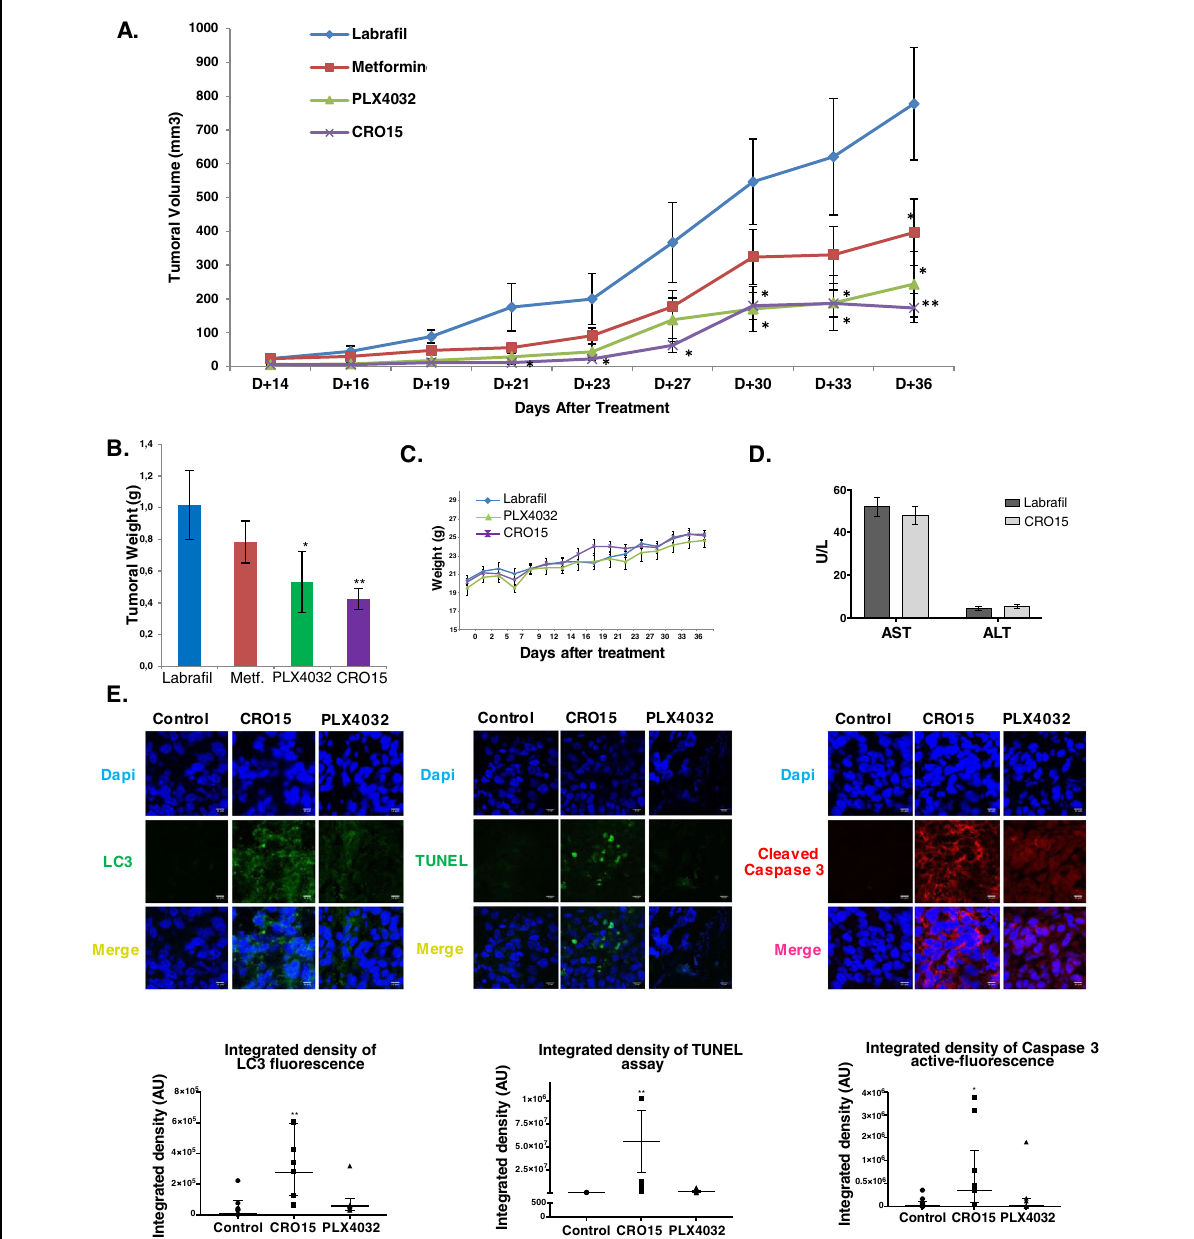
Fig. 6 CRO15 decreases tumor growth in mouse models. A Female immune-de fi cient BALB/c nu/nu (nude) mice were inoculated subcutaneously with 1.0 × 10 6 A375 cells. After 4 days, mice ( n = 6 in each group) were treated with CRO15 (0.7 mg/mouse/day), PLX4032 (0.7 mg/ mouse/day) or vehicle (Labra fi l). Tumor growth curves were determined by measuring the tumor volume. The bars indicate the mean ± SEM. * p < 0.05; ** p < 0.01. B Tumor weight of A375 xenograft after mouse euthanasia. The bars indicate the mean ± SEM * p < 0.05. C. Mice weight over the course of the experiment. D Quanti fi cation of hepatic transaminases (AST and ALT) on plasma of nude mice treated with vehicle or CRO15 at end point. E Immuno fl uorescence staining on xenograft tumor sections. LC3B (green) and active caspase 3 (red) were immunolabeled, and apoptotic cells were visualized with a TUNEL kit. Nuclei were visualized with DAPI (blue). Integrated density was determined for each condition on Fuji. Data are geometric means with 95% CI of three independent experiments performed in triplicate. * p < 0.05; ** p < 0.01; *** p <